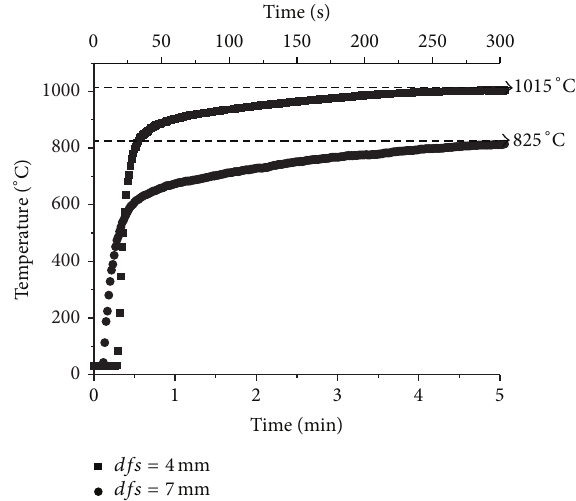
Figure 1: Heating rate and deposit temperature of ZnO nanorods and microclusters grown by the HFCVD technique.